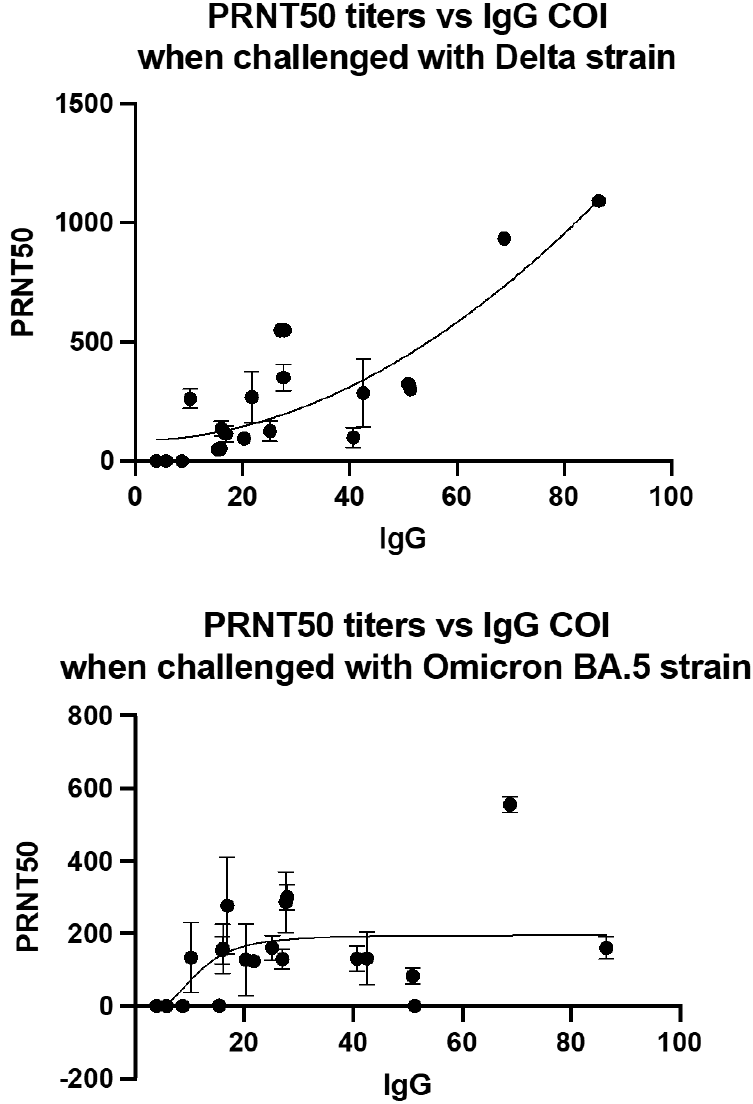
Figure 3. Correlation of PRNT50 titers with IgG COI when challenged with Delta and Omicron variants of SARS-CoV-2. Viral load of 6 × 10 3 PFU/mL (30 plaques/well) were added to Vero-E6 cells. Data represented mean ± SD of two biological replicates. µ = 0.05.